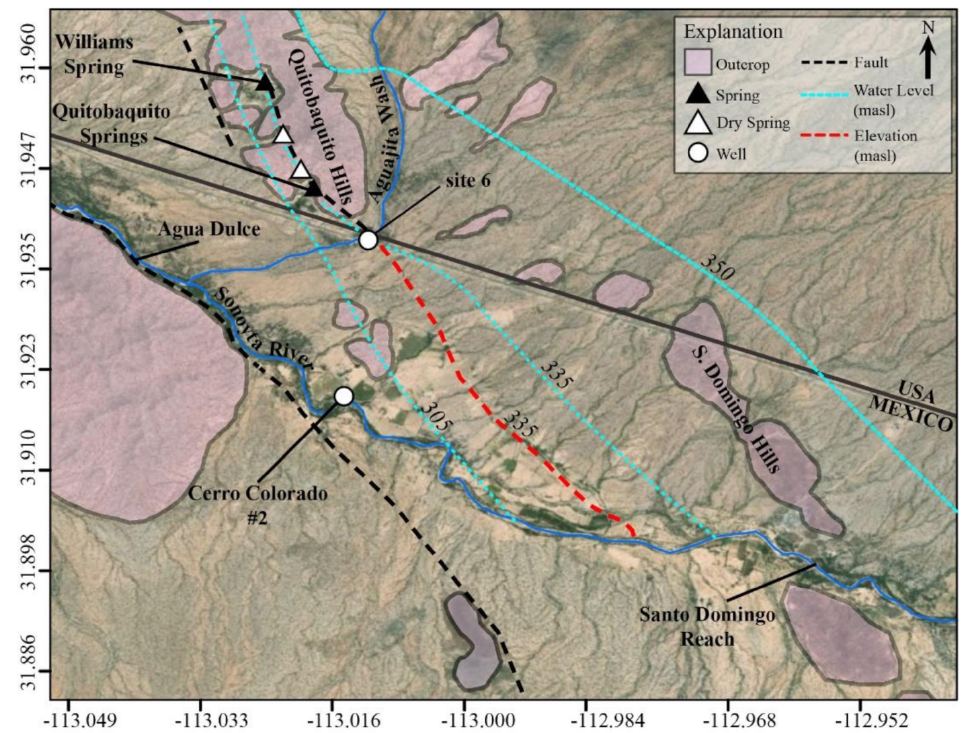
Figure 12. Quitobaquito Springs area. Red dotted line shows the 335 m elevation contour and a hypothetical fault, related to the fault system that created Quitobaquito, extending into Mexico.